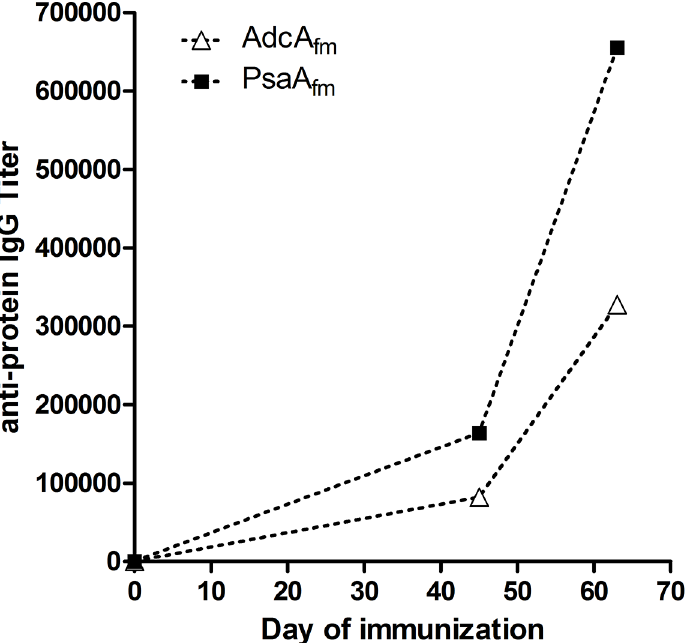
Fig 1. Protein specific IgG antibody titer curves. AdcA fm (black squares) and PsaA fm (white triangles) specific IgG titers of sera raised against the corresponding protein at days 0, 45 and 63 of the immunization procedure.